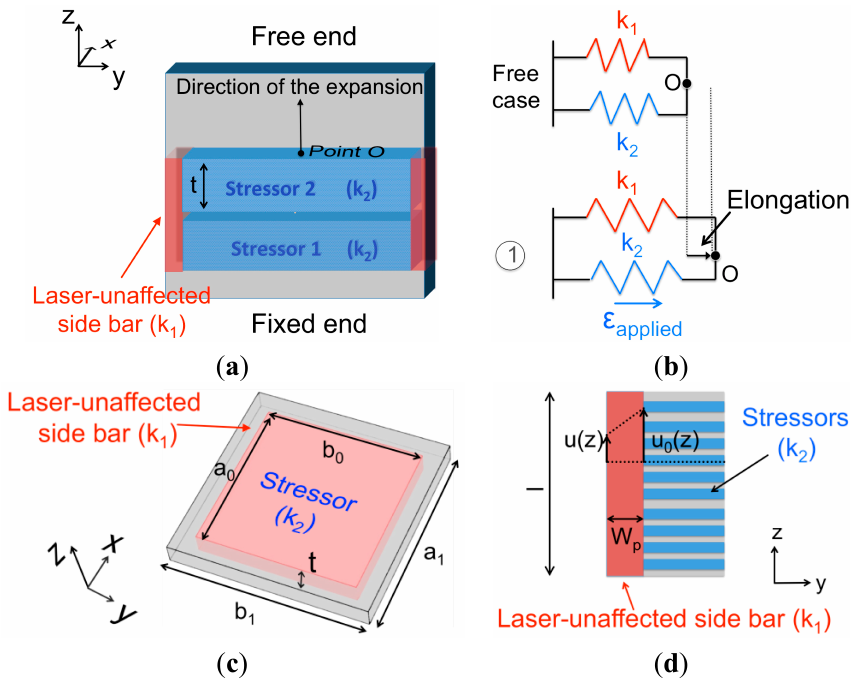
Figure 3. ( a ) 2D visualization of the loading process during the writing of the stressors.